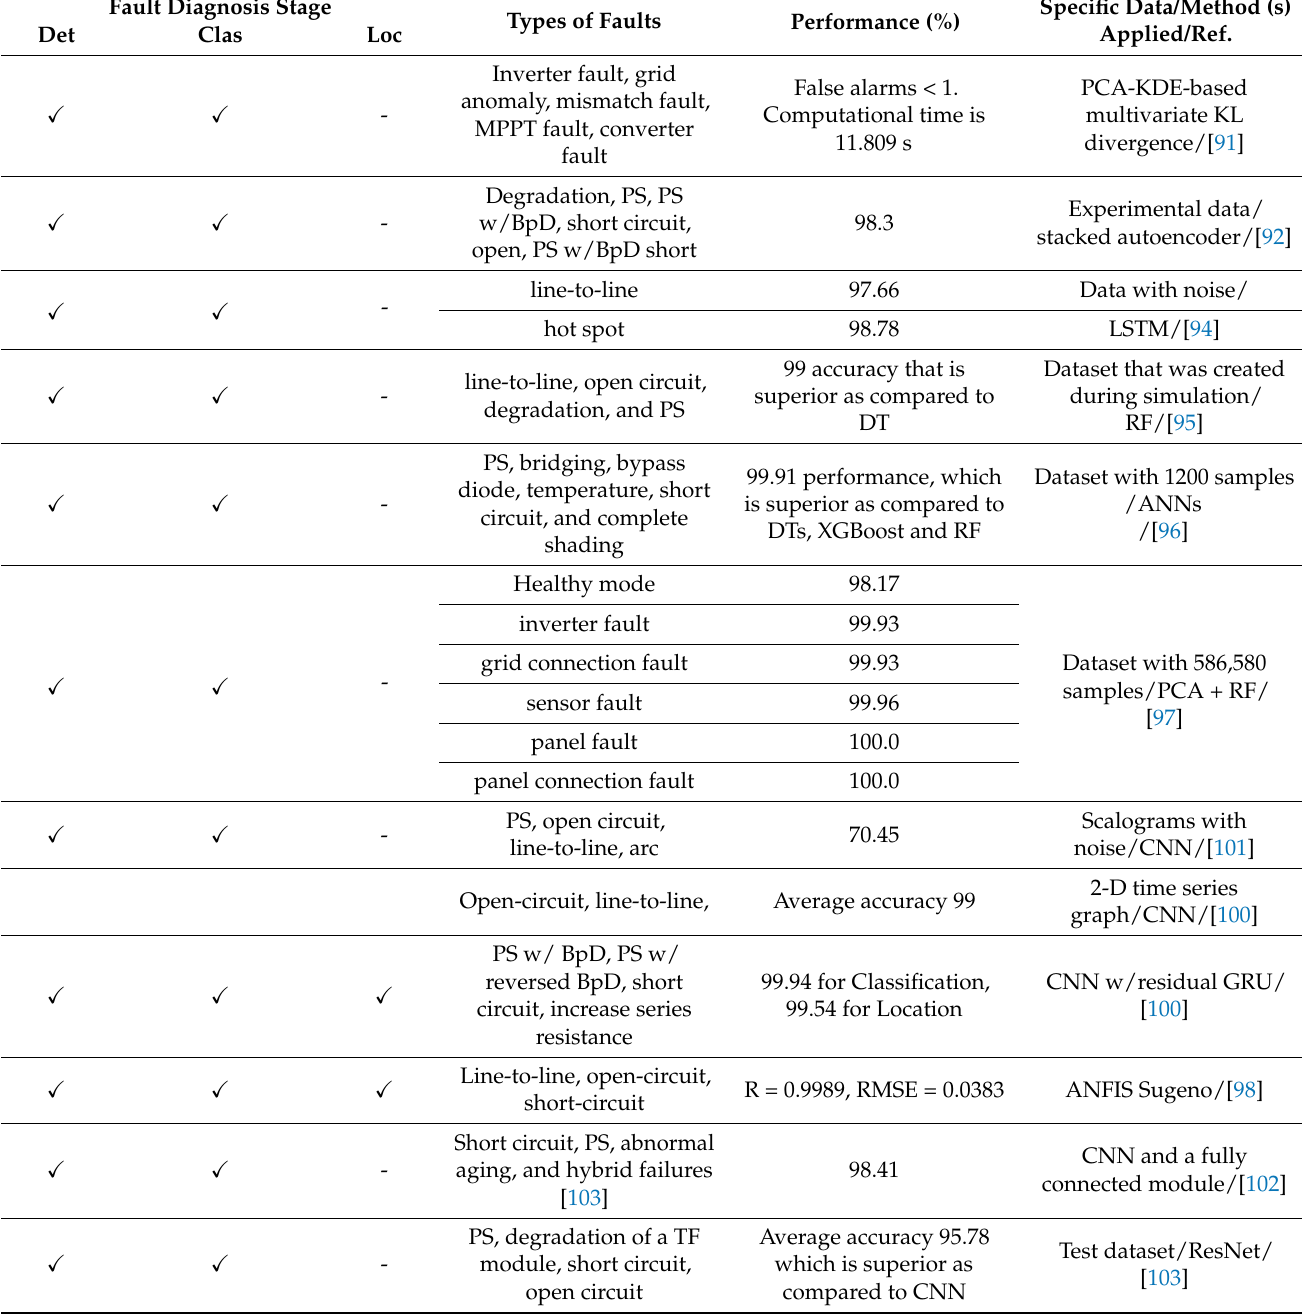
Table 9. Summary of the ML models for PV failure